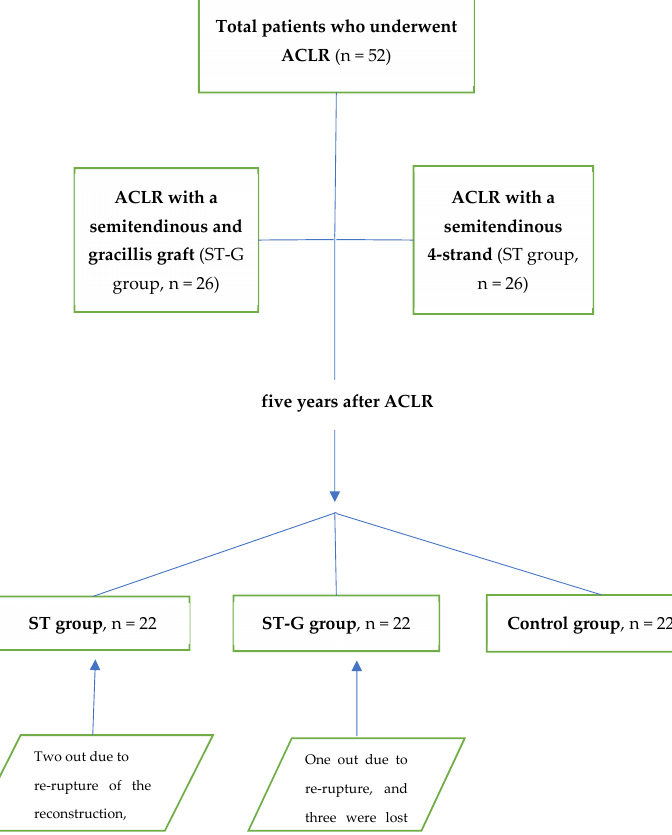
Figure 1. Method of assessment.